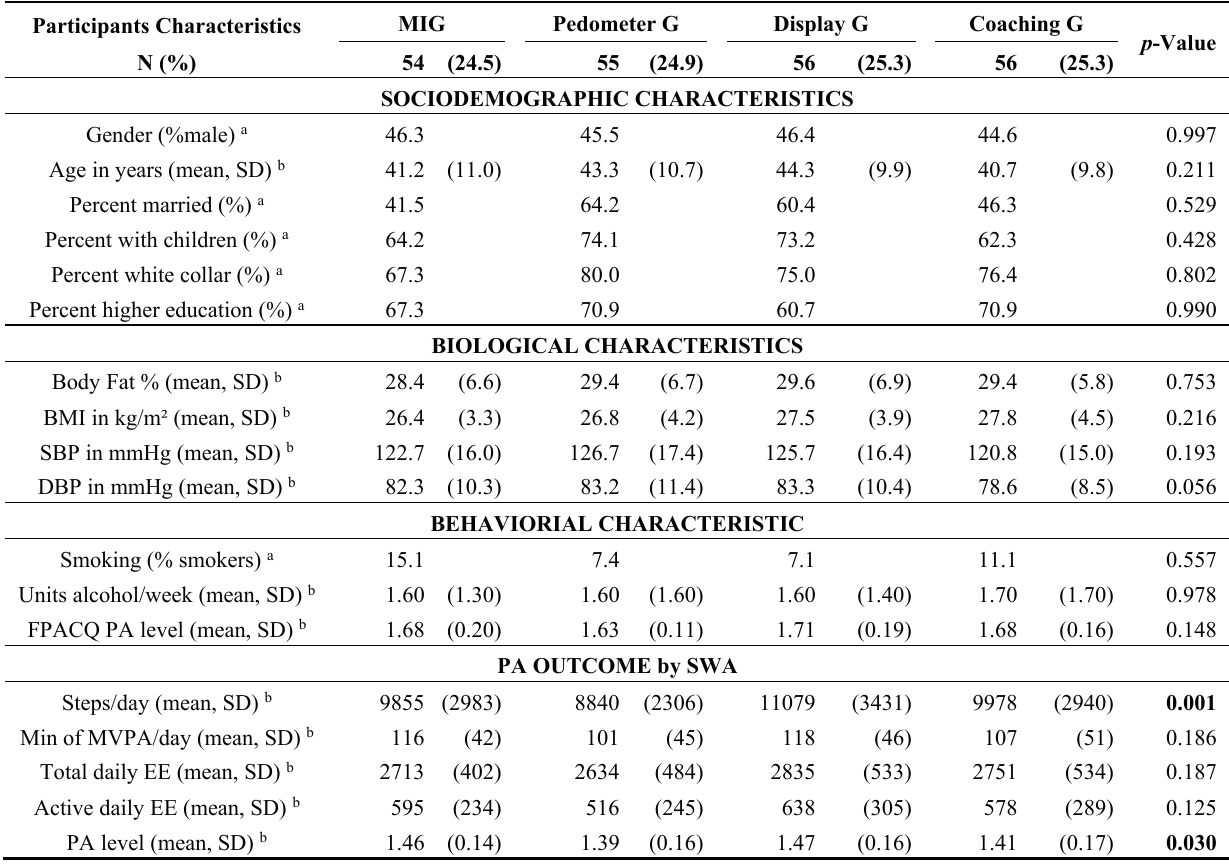
Table 1. Baseline participant